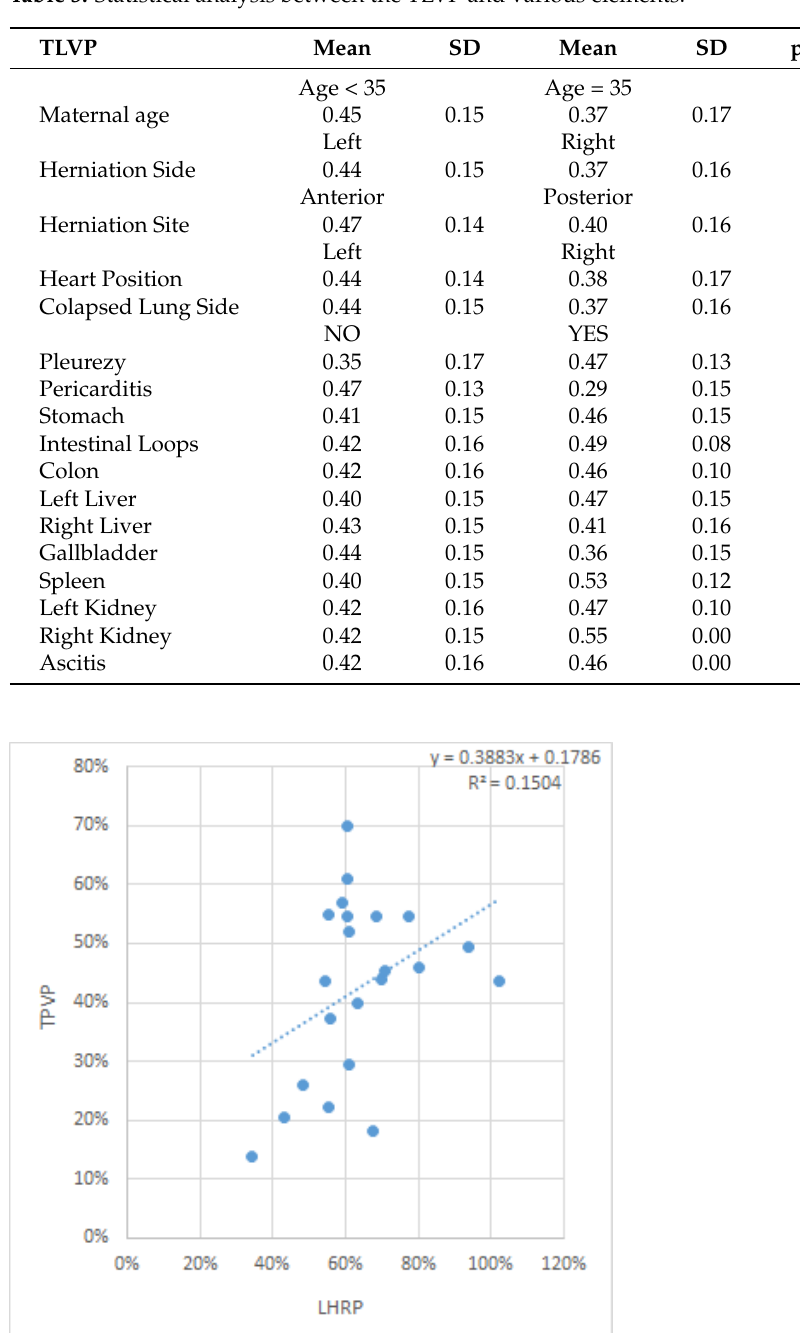
Table 3. Statistical analysis between the TLVP and various elements.